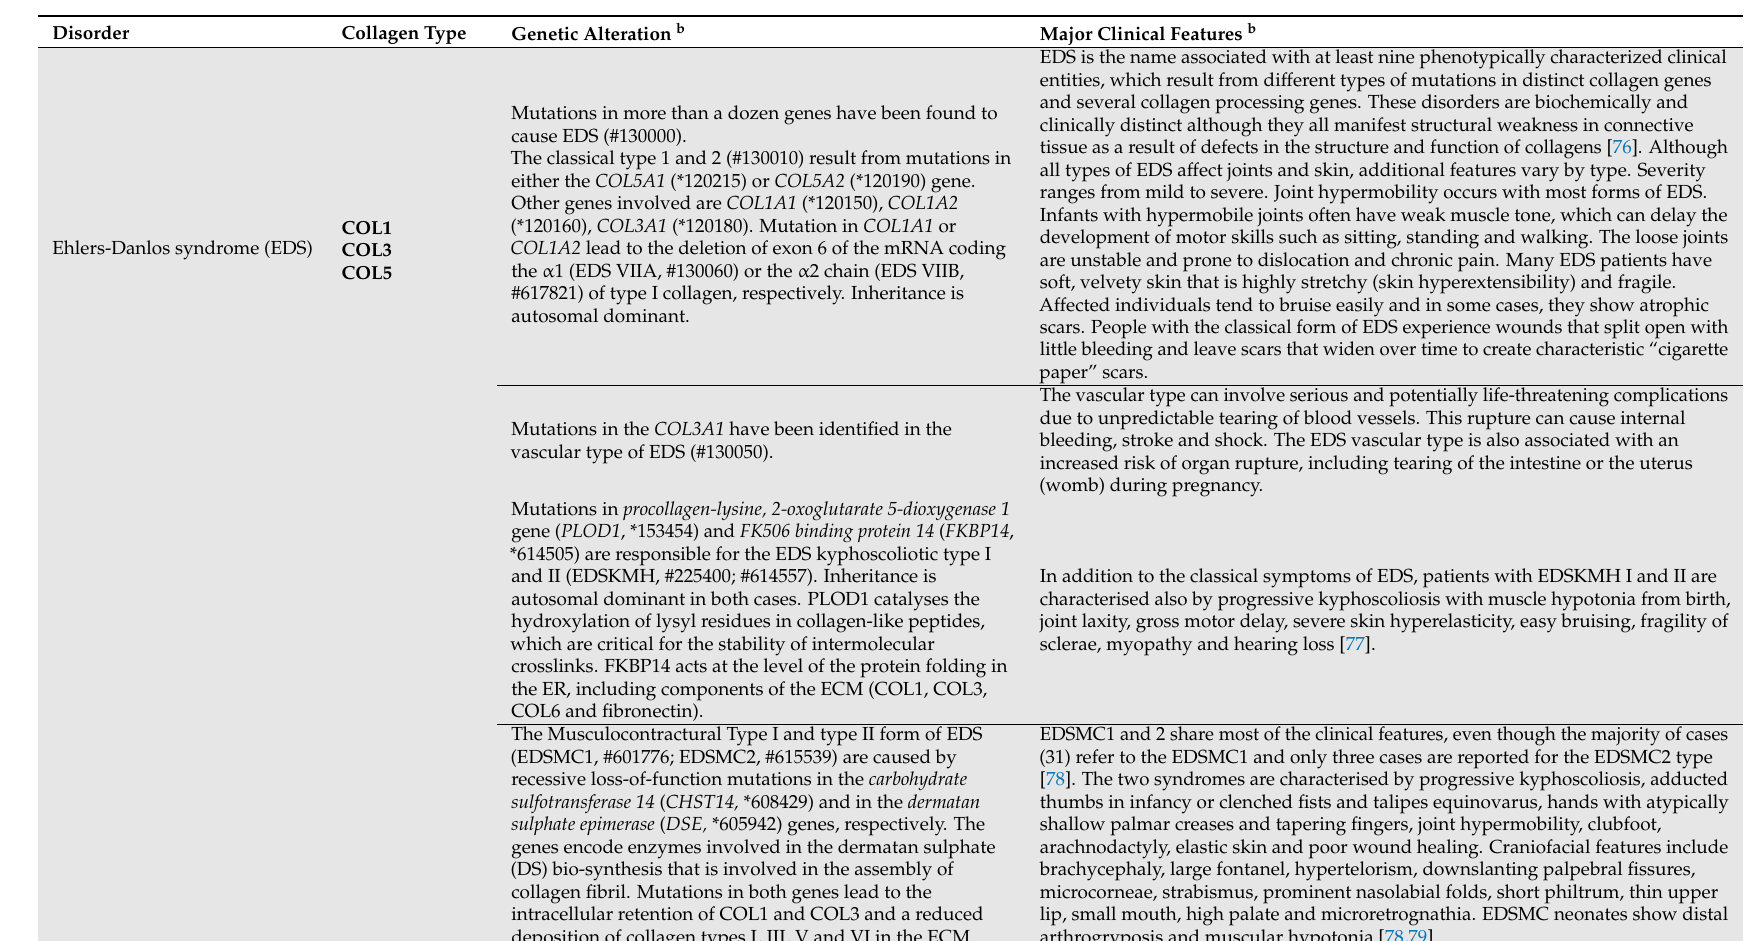
Table 1. Hereditary disorders resulting from collagen structural alterations